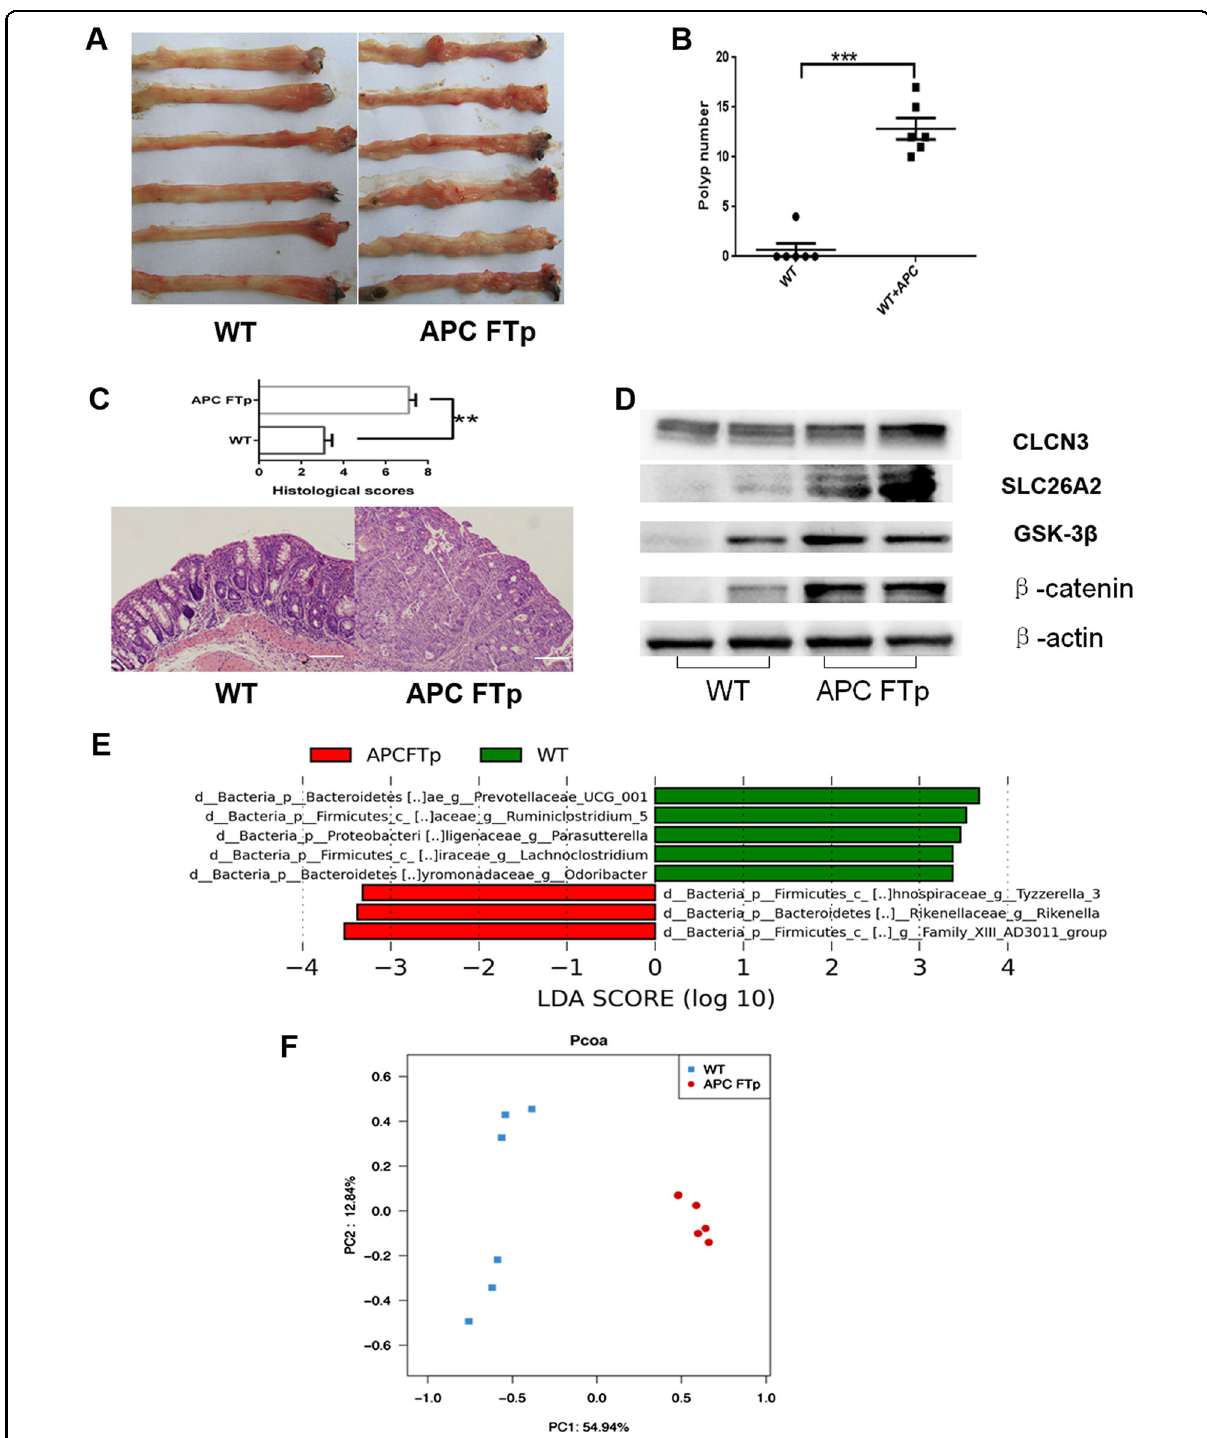
Fig. 2 Microbiota modify the host genotype to colon cancer. a Images of the distal colon from APC FTp and WT mice after AOM/DSS tumorigenesis. b Comparison of polyp numbers between APC FTp and WT mice ( n = 6). Data are represented as the mean ± SEM. P < 0.05; ** P < 0.01; *** P < 0.001; by unpaired Student ’ s t test. c Histological scores and representative HE staining of distal colon sections obtained from APC FTp and WT mice after AOM/DSS tumorigenesis. d Western blot of intestinal CLCN3, SLC26A2, GSK3 β and β -catenin expression from APC FTp or WT mice after AOM/DSS tumorigenesis. e Featured altered microbial communities between APC FTp and WT mice after AOM/DSS tumorigenesis ( n = 6) from Illumina Miseq sequencing. Data were analyzed by the Mann – Whitney test. f PCoA of 16S rRNA sequences of gut microbiota obtained from the APC FTp and WT mice ( n = 6) from Illumina Miseq sequencing. PC1 and PC2 explain 54.94 and 12.84% of the variation, respectively. n no signi fi